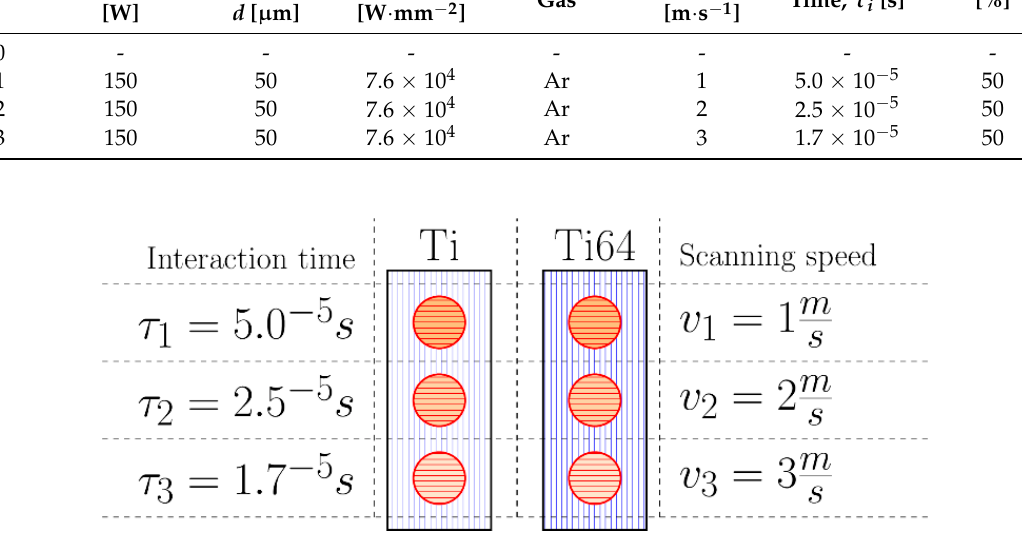
Figure 3. Samples layout during laser treatment process. Samples for LST were put in the chamber of the 3D printer on the steel platform heated up to 200 ◦ C. The laser-treated areas were circles with a diameter of 11 mm. The as-deposited materials and the sample after LST are shown in Figure